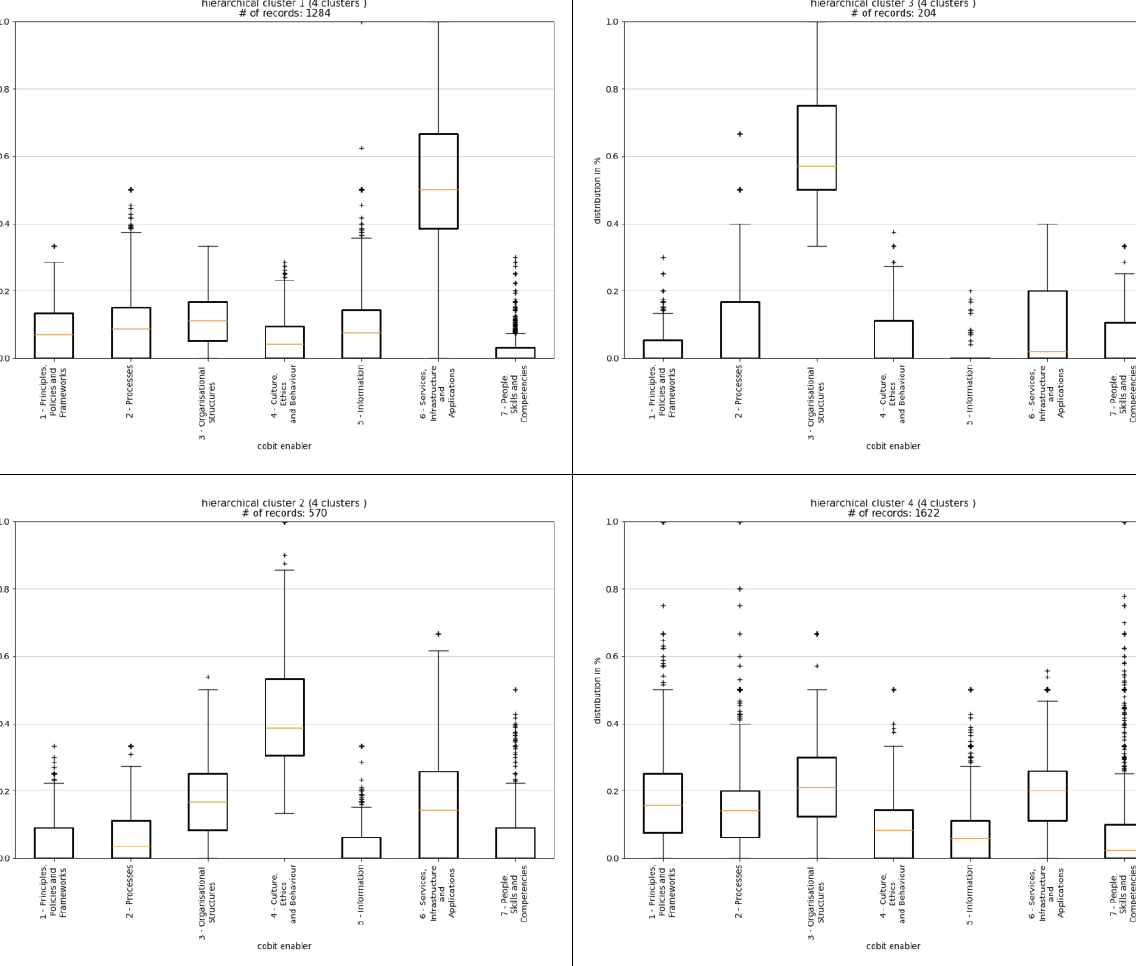
Figure 6. Histograms for each cluster (4